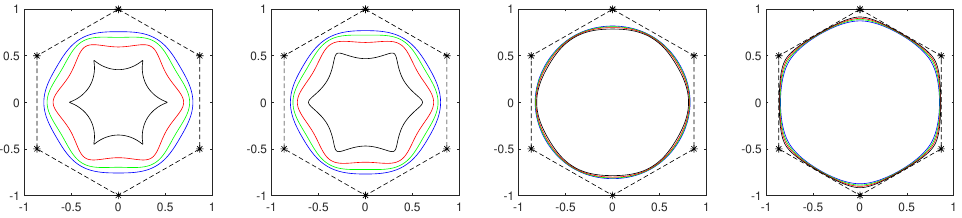
Figure 4. Limit curves generated by the scheme { S a k } k ≥ 0 with v 0 = − 0.5, − 0.4, cos ( pi /3 ) ,5 (from left to right) and β = 0.5 (blue), 1 (green), 1.6 (red), 2.5